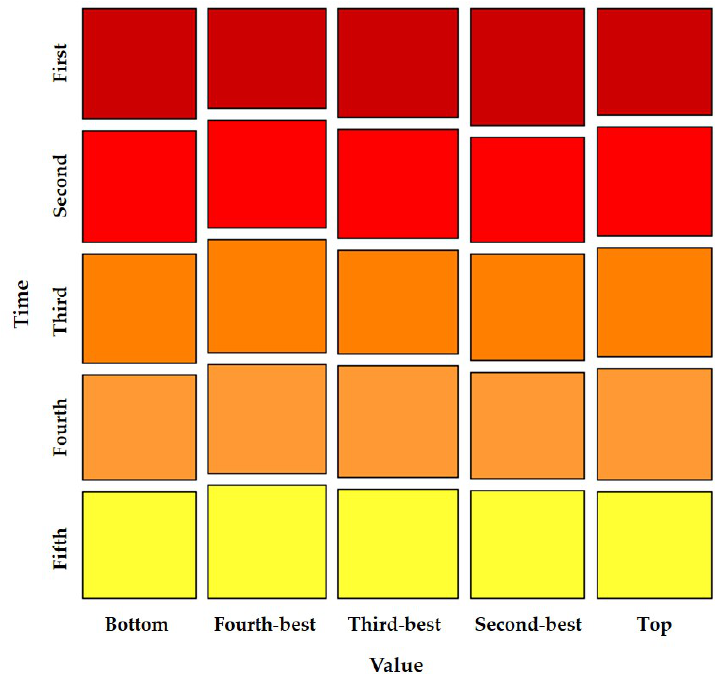
Figure 1. Graphical representation of the probability of executing a SC given the preference of a miner.